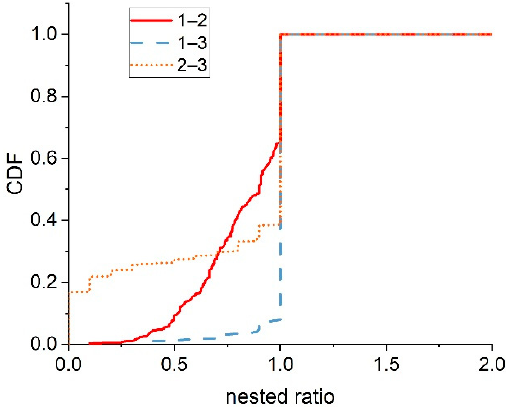
Figure 9. CDF for nested ratio in possible nested inference.